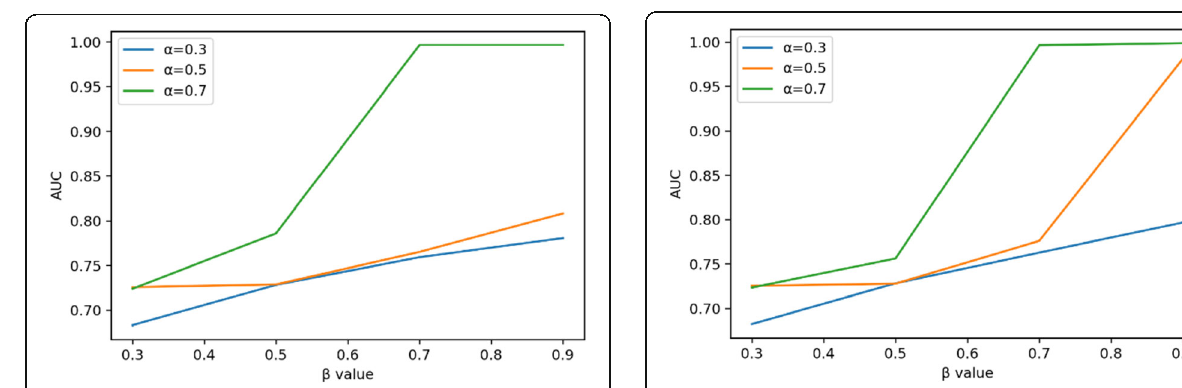
Fig. 10 The different parameters are employed in the function WCN TKA , and λ = 0.3 to obtain AUC values. α = 0.3, α = 0.5, α = 0.7